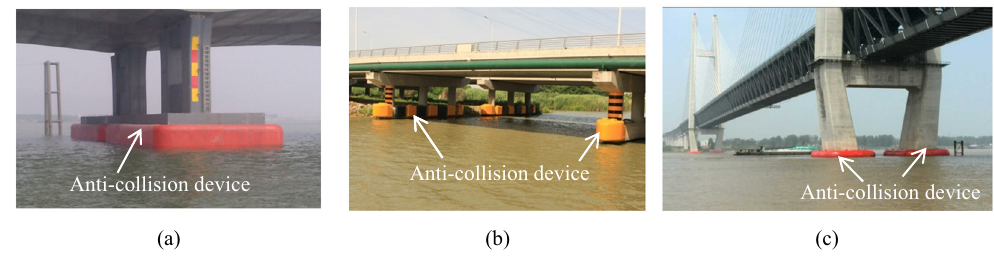
Figure 1: Application of the orthogonal lattice web reinforced composite sandwich panels as anti - collision devices: ( a ) Guang Zhou to Shen